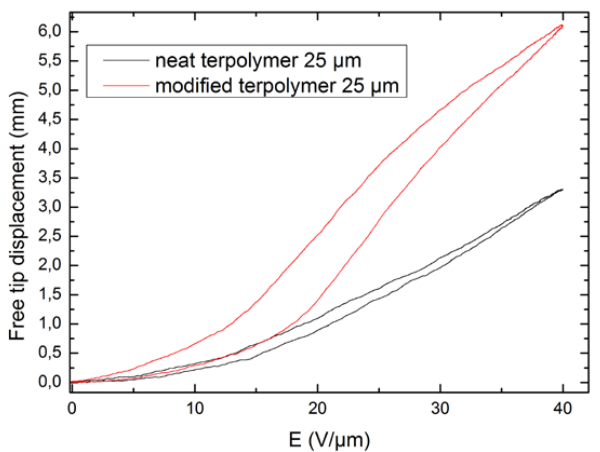
Figure 10. Free displacement versus electric field at 0.1 Hz for two terpolymer compositions.